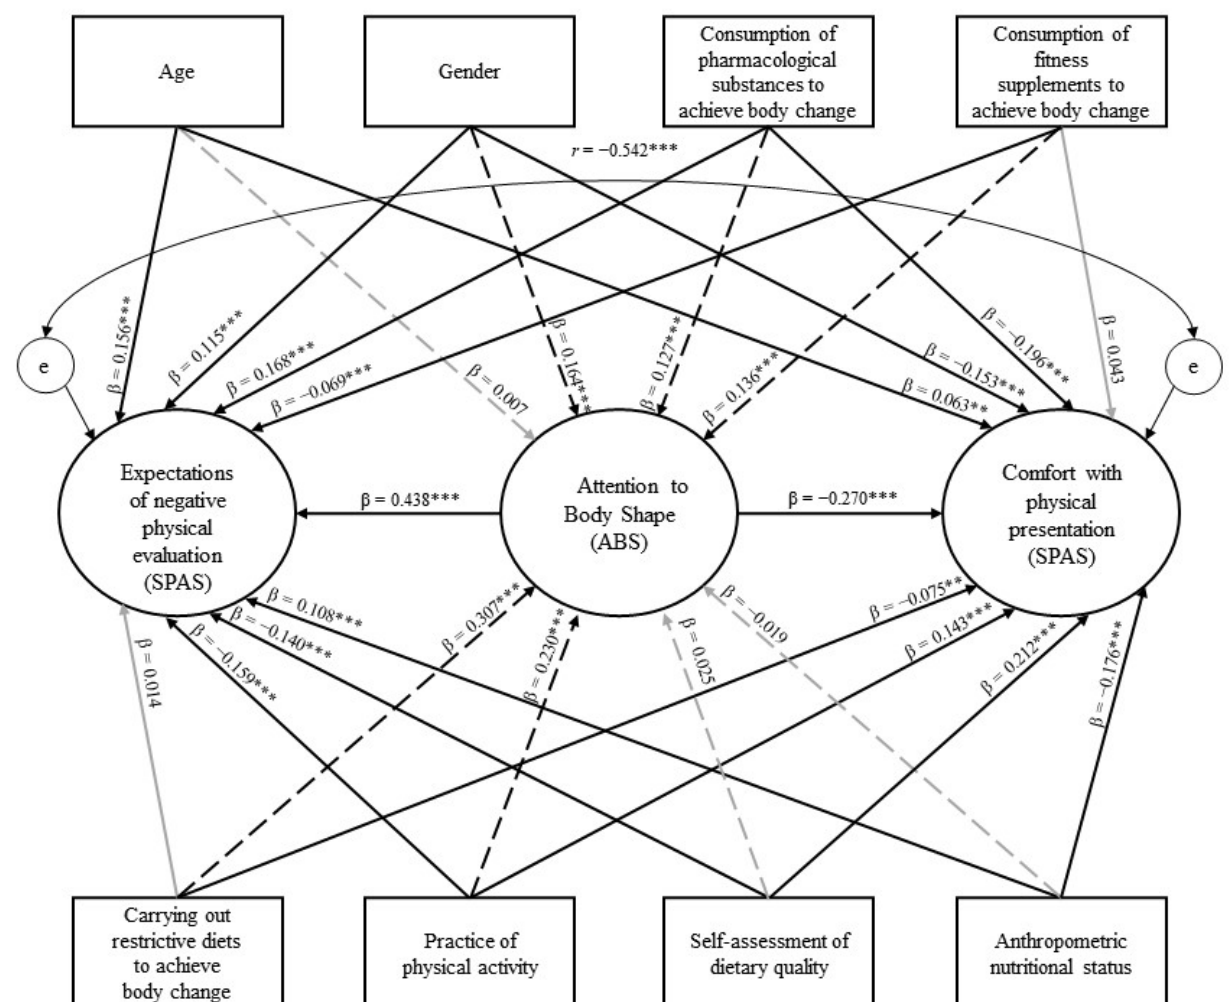
Figure 1. Hypothetically causal structural model designed to verify the relationship between the study variables. Note. *** p < 0.001, ** p < 0.01. Circles represent latent variables and rectangles represent manifest variables. Arrows: black indicates significant paths; grey indicates non-significant paths; dotted lines indicate mediation paths (confirmed by Sobel’s test). The final model is composed of all significant paths in black color. β : estimate of the path, e: residue, r: correlation coefficient, ABS: Attention to Body Shape Scale, SPAS: Social Physique Anxiety Scale.